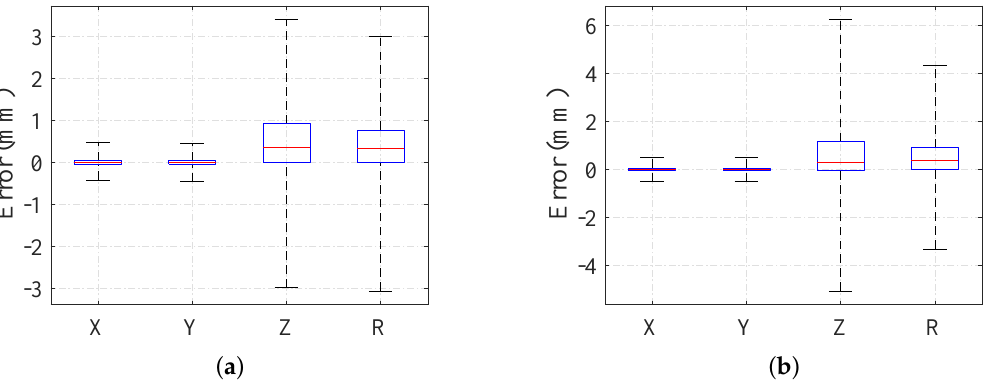
Figure 6. Simulation of the pose errors over a 500-mm distance with random noise levels of: ( a ) 0.5 pixels; and ( b ) one pixel.